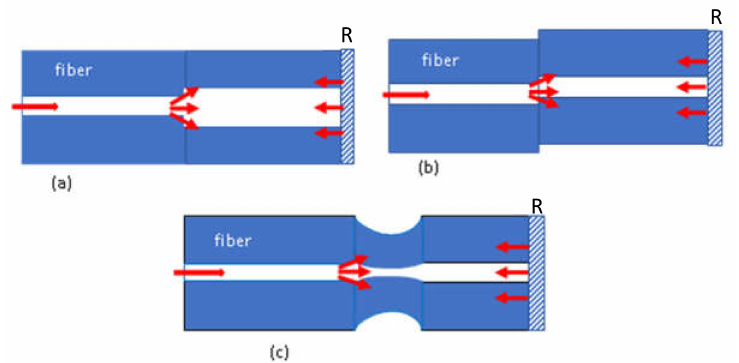
Figure 3. Various types of FOMI sensors: ( a ) core diameter mismatch with larger core fiber, ( b ) core diameter offset, ( c ) core diameter mismatch using a tapering segments of fiber.